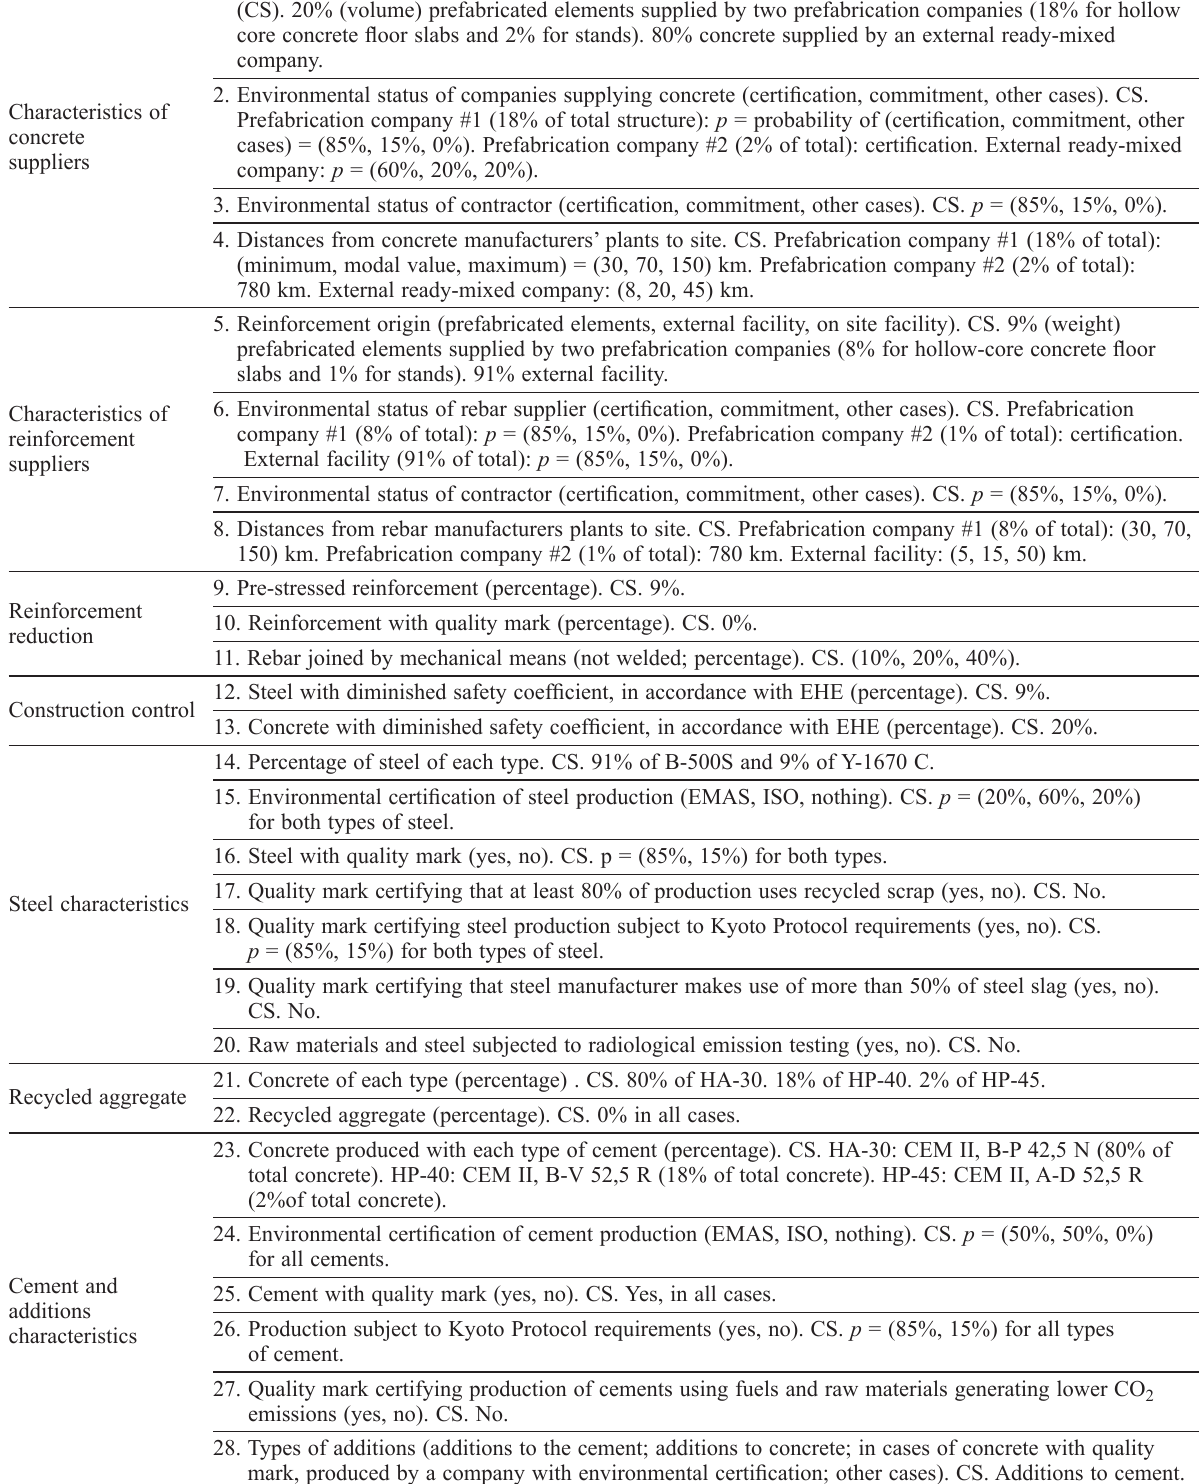
Table 1. Model variables and their values in the case study. CS = case study for Scenario #1 of Table 3. p = ( p 1 , p 2 , p 3 ) = probability of (alternative1, alternative2, alternative3) for discrete variables. (